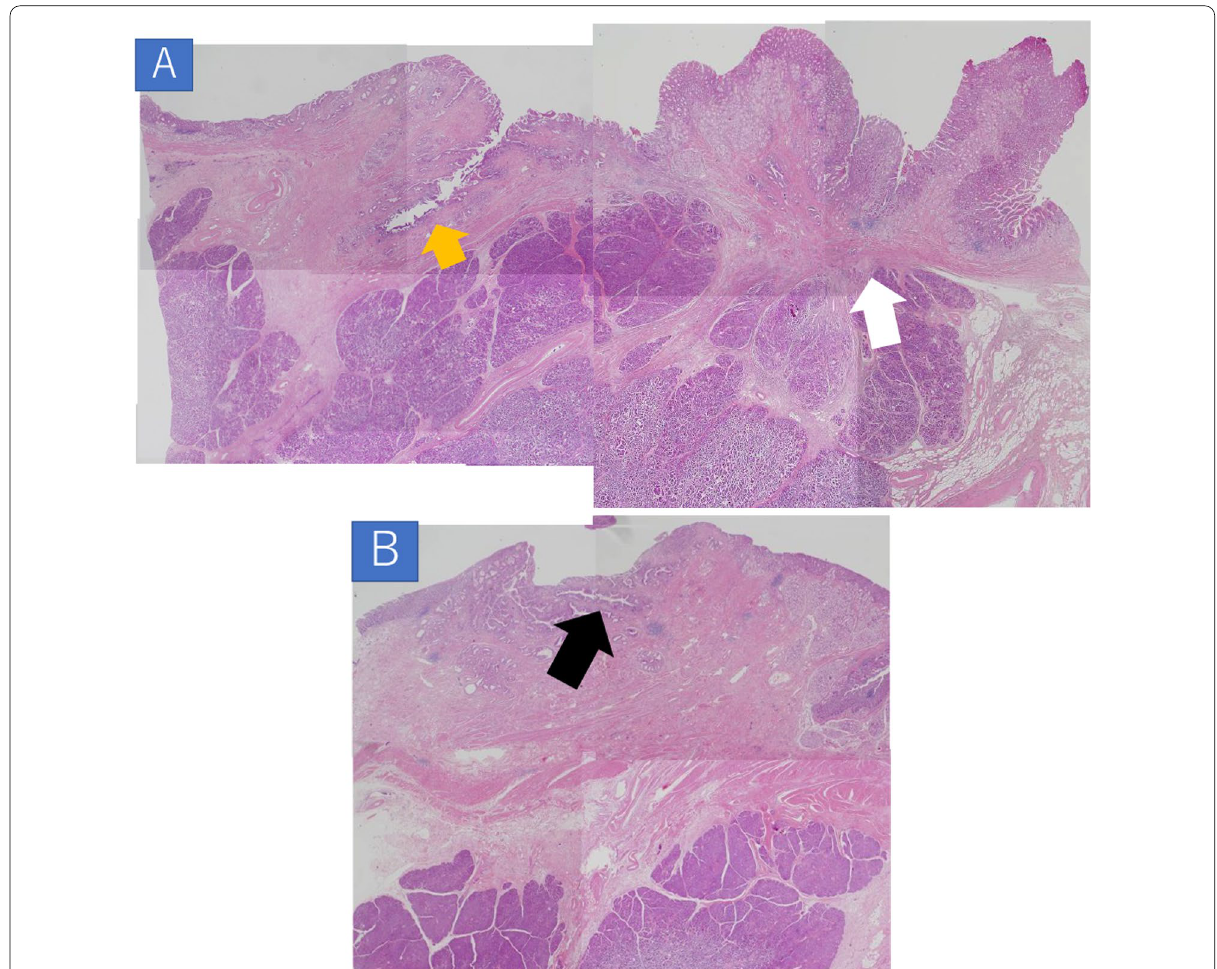
Fig. 5 Histopathological findings. A , B The CBD and pancreatic duct were separate openings with epithelial cells. A Duodenal stenosis: fibrosis without tumor cells (white arrow). Opening of the CBD: no sphincter muscle structure (orange arrow). H&E stain, separate opening of the pancreatic duct (black arrow) with only the muscle structure. H&E stain,